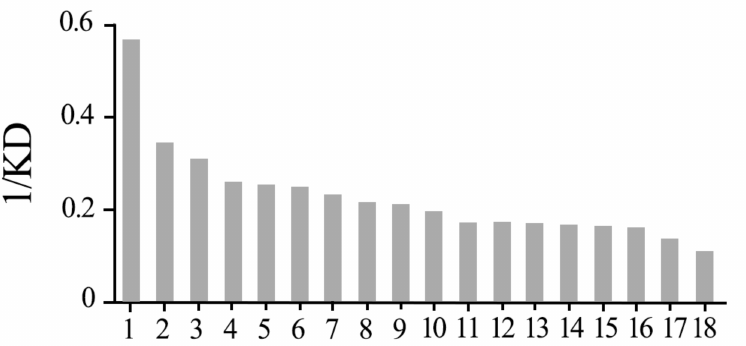
Figure 4. Binding affinities of Lmig CSPIII to certain compounds. Only those with an IC 50 less than 20 µ m are regarded as able to bind with Lmig CSPIII. Eighteen chemicals were screened and plotted on the chart. KD, dissociation constant. 1-18 represent α -Amylcinnamaldehyde, Oleamide, Diethyl phthalate, Dibutyl phthalate, Benzeneacetonitrile, Guaicacol, Benzaldehyde, Dodecyl 2- methylacrylate, Hexadecanol, Cyclohexanol, 2-Heptaone, DL-sec-phenethyl alcohol, trans-2-Hexenal, 3-Methy-1-butanol, 2,5-Dimetylpyrazine, Phenol, Pentadecanol,